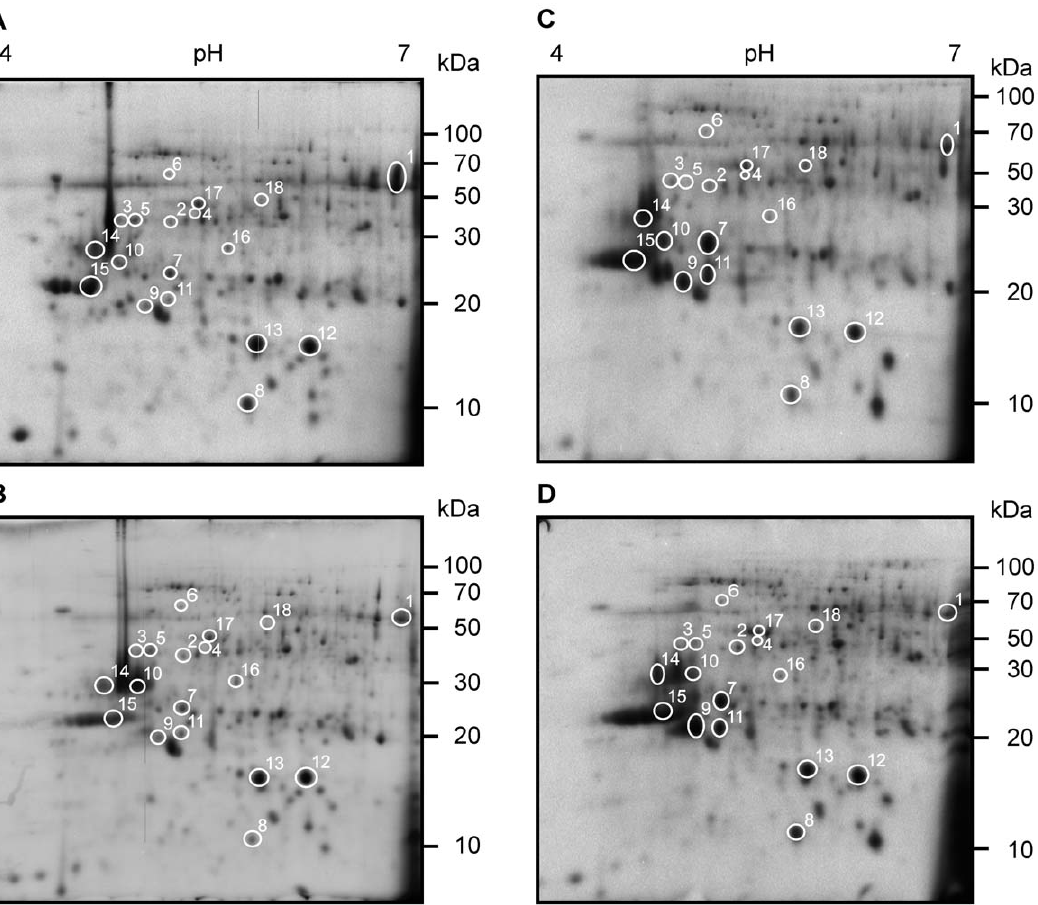
Figure 2. Protein profiles in 2-DE of total soluble proteins of Xcc and D XacPNP-infected citrus leaves. Equal amounts of urea-buffer extracted proteins (200 m g) were separated on 7 cm pI 4–7 linear gradient strips in the first dimension and on 12% SDS-PAGE in the second dimension and stained with Coomassie blue. Spots numbers are the same as in Figure 1. Numbers on the right indicate molecular mass in kilodalton (kDa). (A) Citrus leaves inoculated with Xcc wild type (XccWT) 3 dpi and (C) 6 dpi and (B) with D XacPNP 3 dpi and (D) 6 dpi.